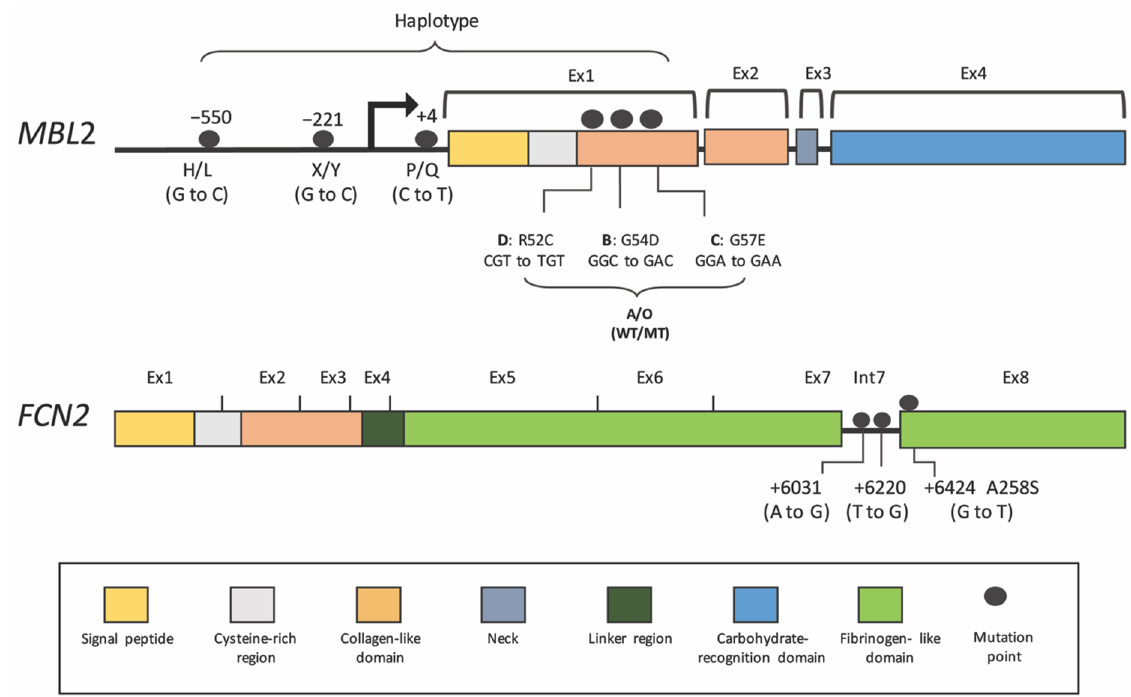
Figure 3. Single Nucleotide Polymorphisms (SNPs) on MBL2 and FCN2 genes associated with Dengue. See text and Tables 2 and 3. Table 2. Single-nucleotide polymorphisms in the MBL2 and FCN2 genes associated with dengue disease. Protein